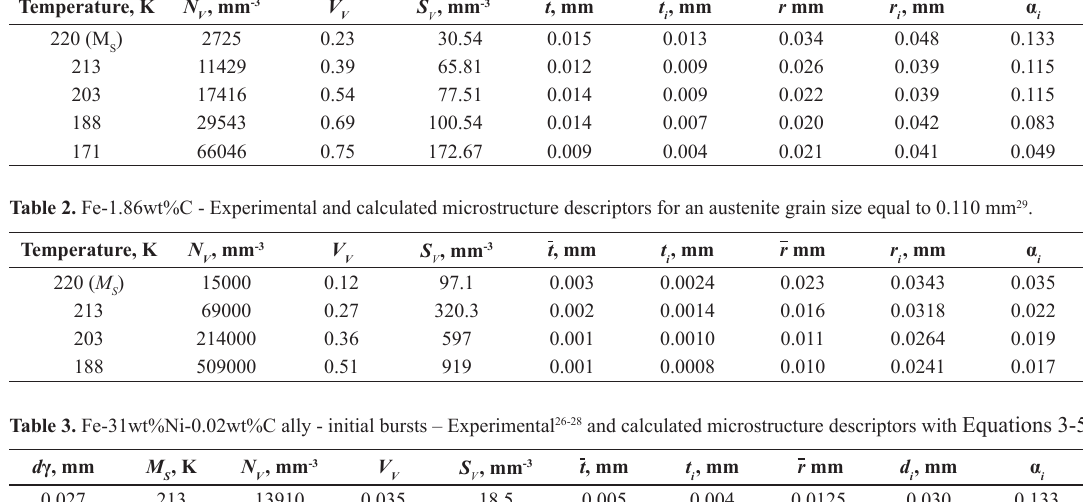
Table 1. Fe-31wt%Ni-0.02wt%C alloy - Experimental and calculated microstructure descriptors for an austenite grain size equal to 0.142 mm 26-28 . Temperature, K